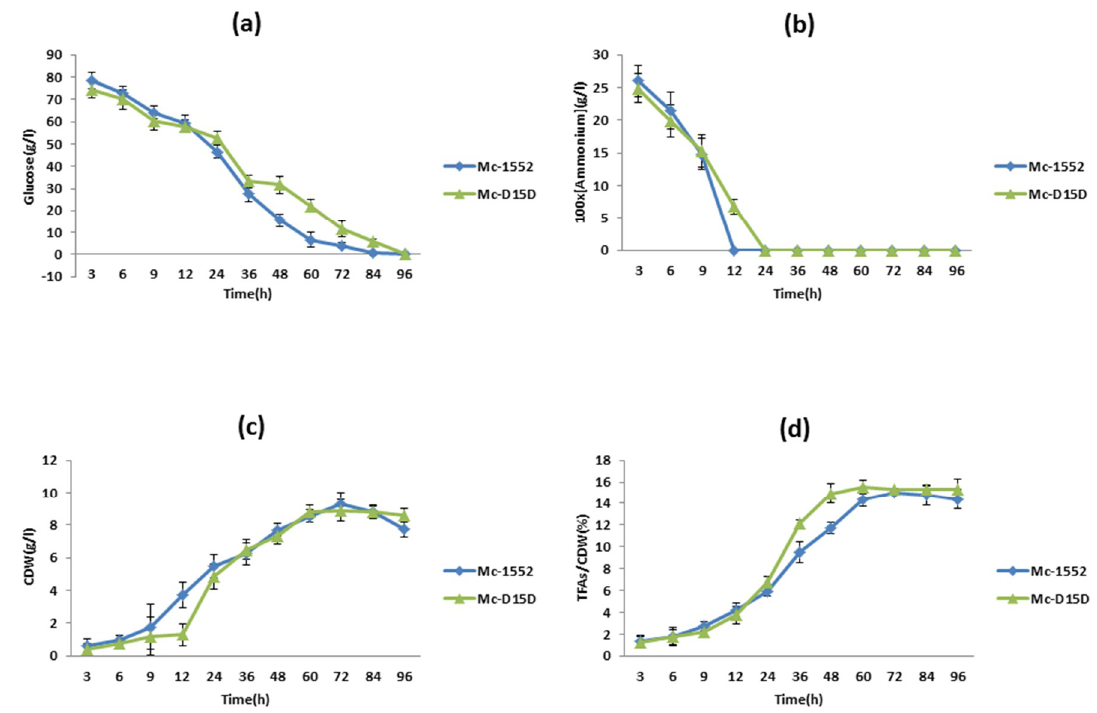
Figure 4. Cell growth and lipid accumulation of D15D overexpressing strains. Recombinant Mc-D15D and control strain Mc-1552 cultures were grown in 1.5 L modified K&R medium and ( a ) glucose concentration, ( b ) ammonium concentration, ( c ) cell dry weight (CDW), and ( d ) lipid content were measured. Samples from the fermenter were taken at the indicated times. The values were mean of three biological replicates. Error bars represent the standard error of the mean.